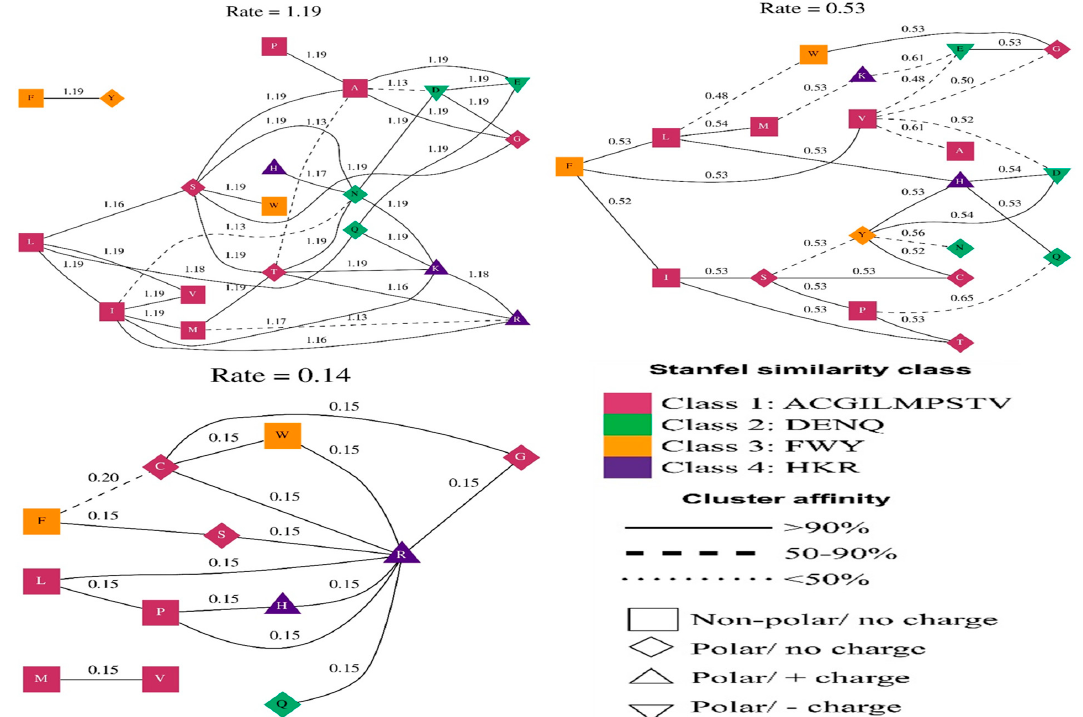
Figure 2. Application of a genetic algorithm (GA) model to identify structural and evolutionary rate clusters from BPIFA1 protein alignments. Maximum-likelihood estimation was used to identify each cluster and GA was used to determine its rate. Table 3. Sites under episodic diversifying selection inferred by MEME.